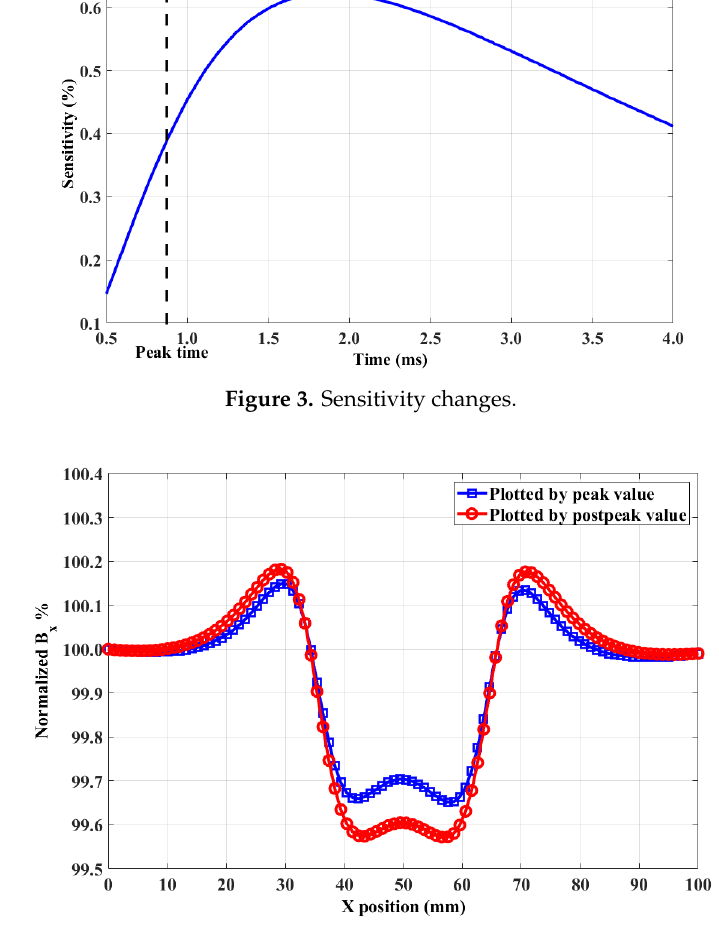
Figure 4. Normalized B x curves plotted by peak and postpeak values.